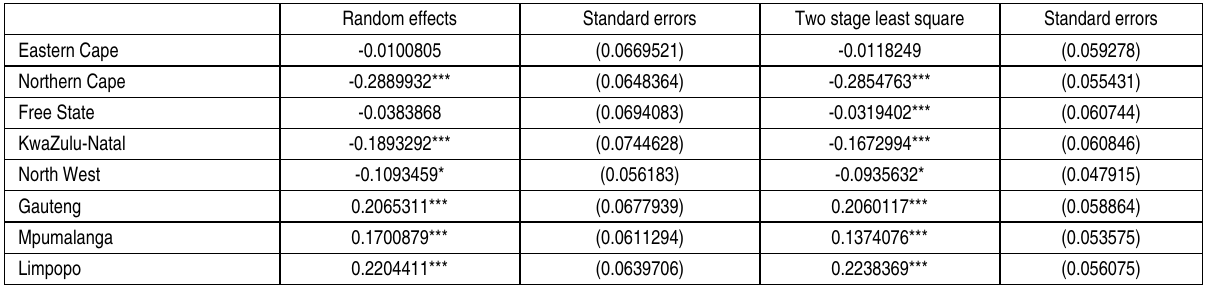
Table 1 (cont.). Random effects and 2SLS estimates of the effect of quality of education on earnings in